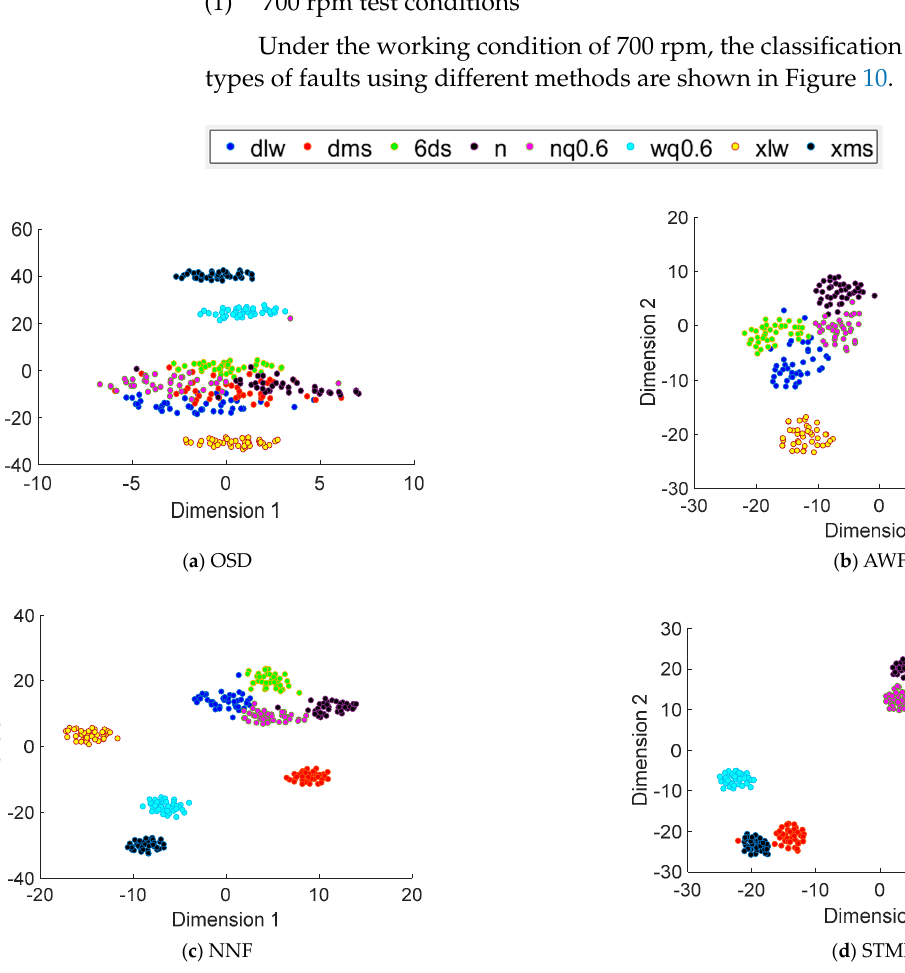
Figure 10. Comparison of eight types of fault classification results under 700 rpm.